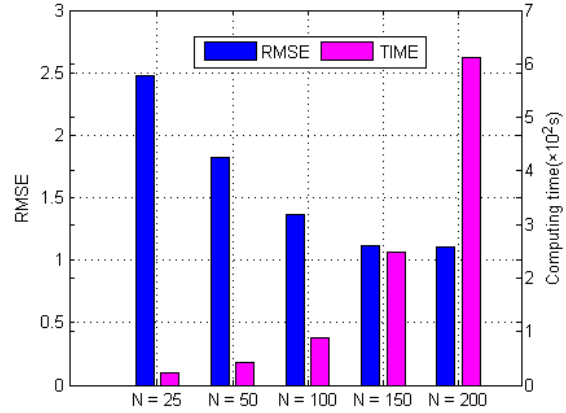
Figure 5. Bar plots of the RMSE and computing time with the same conditions.